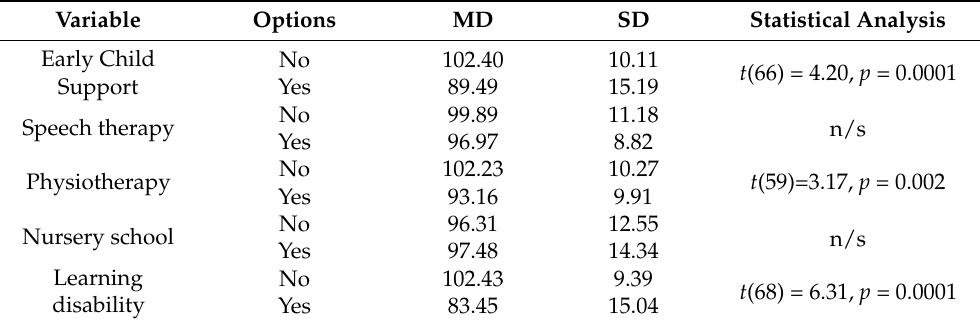
Table 8. Mean values and standard deviations of the global development coefficient in each childcare variable